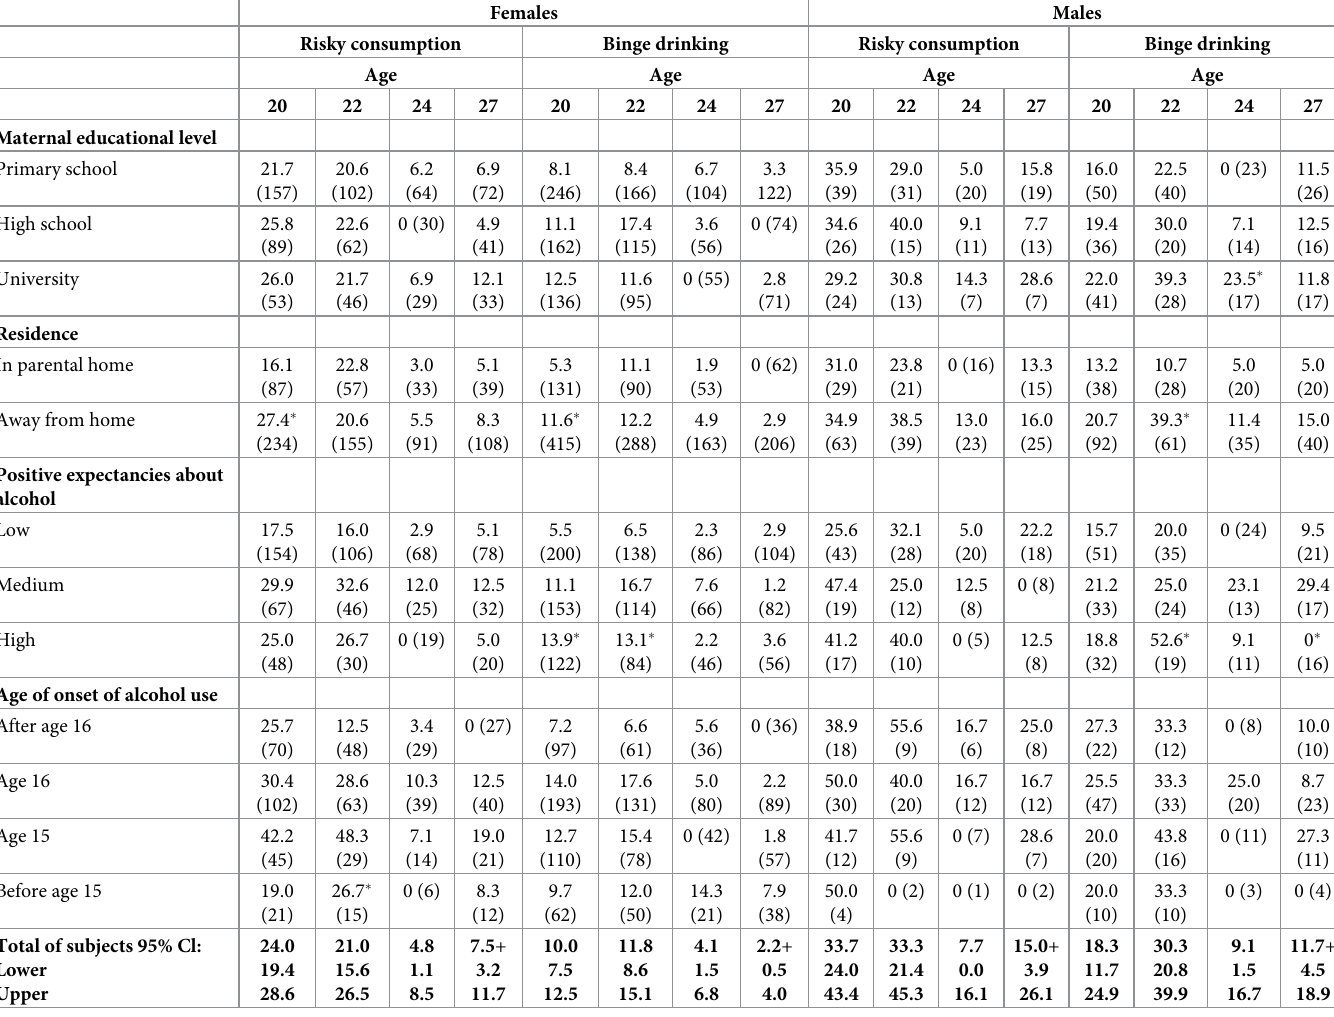
Table 4. Percentages of subjects partaking in risky consumption and binge drinking at age 20, 22, 24 and 27 years, among subjects who did not partake in each of these consumption patterns at age